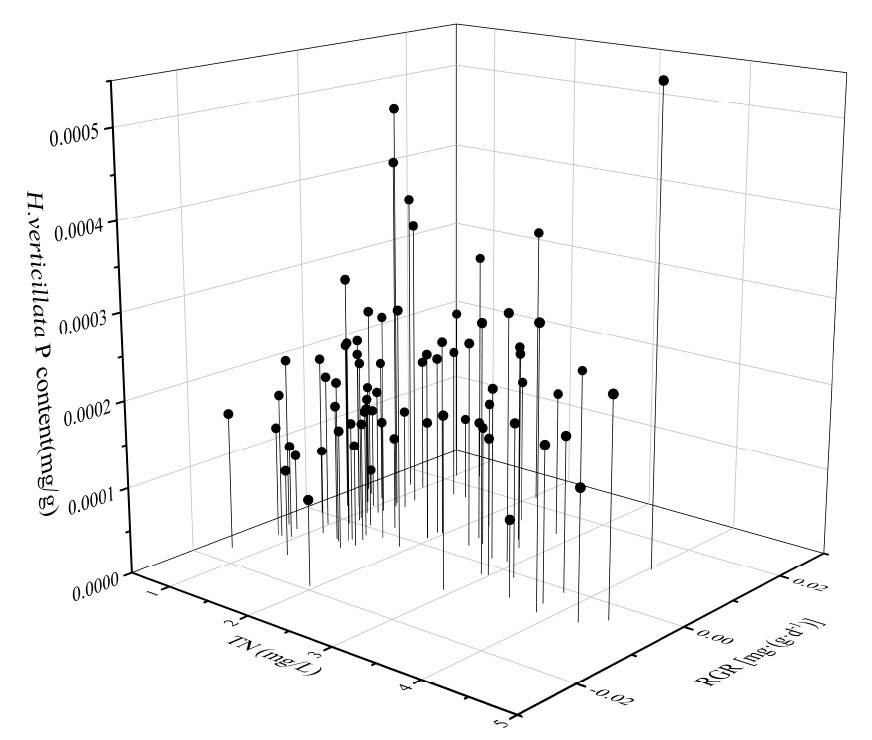
Figure 4. The relationship between H. verticillata P, water TN, and relative growth rate (RGR). C:N ratio of V. natans was negatively correlated with TN content and N:P ratio of water (Table 5, Figure 5). The N content of V. natans was positively correlated with TN content of water. The reduced chi-squared test value was close to 1, indicating that the fitting effect of the nonlinear fitting curve was good (Table 6, Figure 6). The P content of V. natans was positively correlated with RGR of plant (Table 7, Figure 7), and the N:P of V. natans was positively correlated with the TN of the water body. The higher the TN of the water body, the higher the N:P of V. natans . The reduced chi-squared test value was close to 1, indicating that the fitting effect of the nonlinear fitting curve was good (Table 8, Figure 8). The C:P ratio of V. natans was negatively correlated with RGR (Table 9, Figure 9). No significant correlation existed between the C content of V. natans and the above five factors ( p >